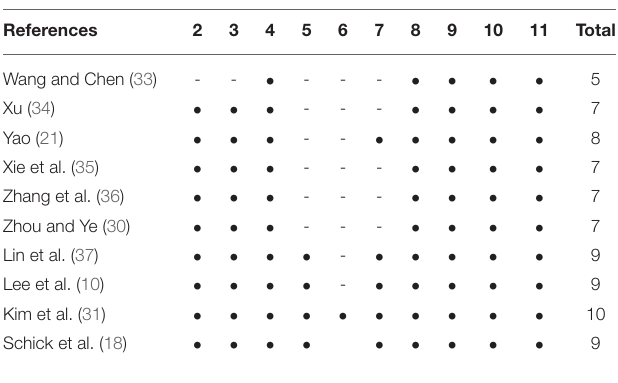
TABLE 3 | Internal validity analysis.